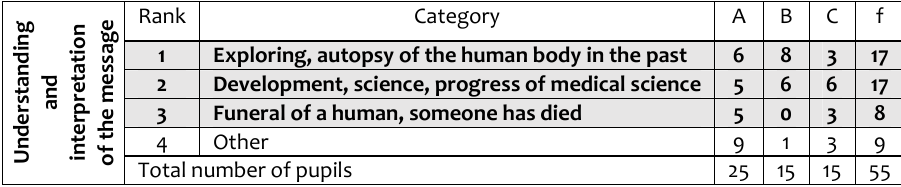
Table 7: Ranking order of the categories of answers regarding the understanding and interpretation of the message of the second example (Rembrandt van Rijn, The Anatomy Lesson of Dr. Nicolaes Tulp, 1632).